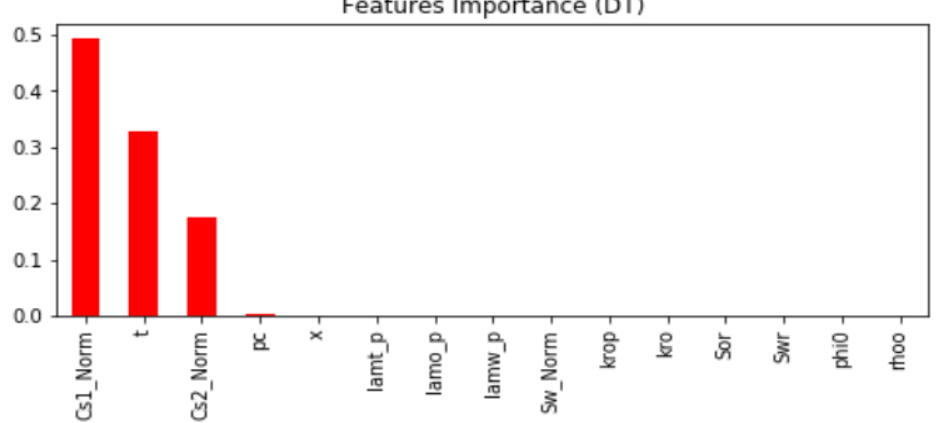
Figure 2. Features importance of (a) DT for predicting C.